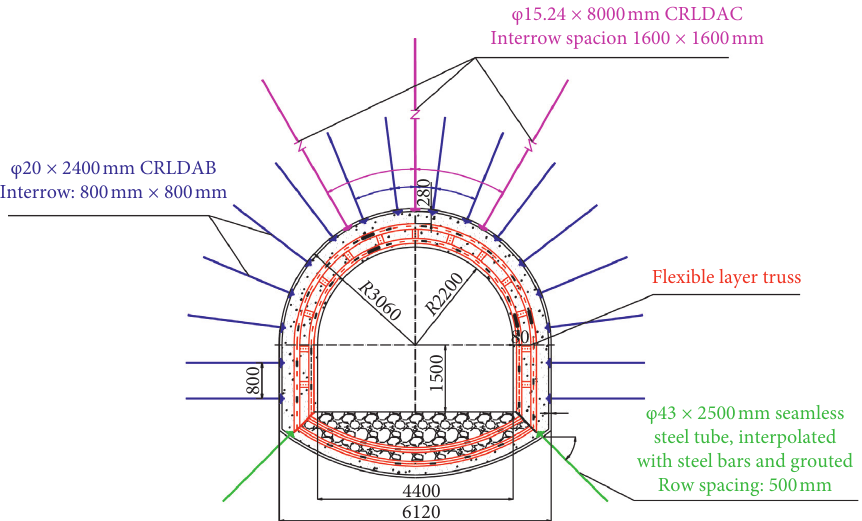
Figure 15: Design scheme of the CRRFC support (un: